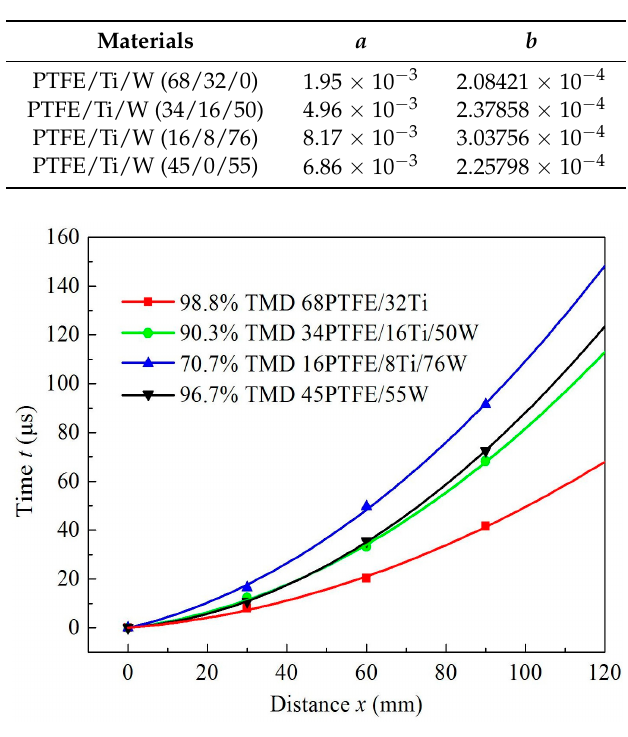
Figure 10. Time–distance curves for shock wave propagation.